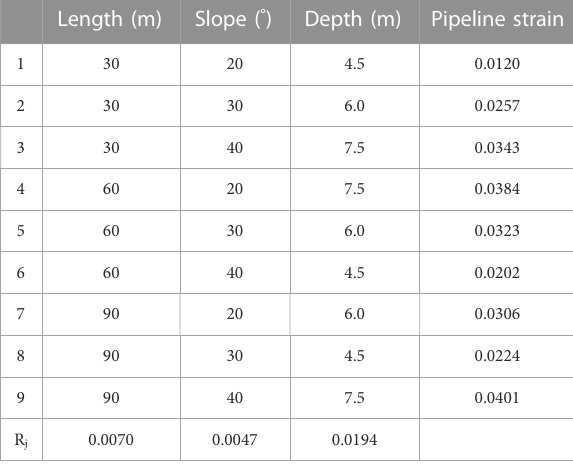
TABLE 5 Orthogonal test comparison of pipelines crossing landslides